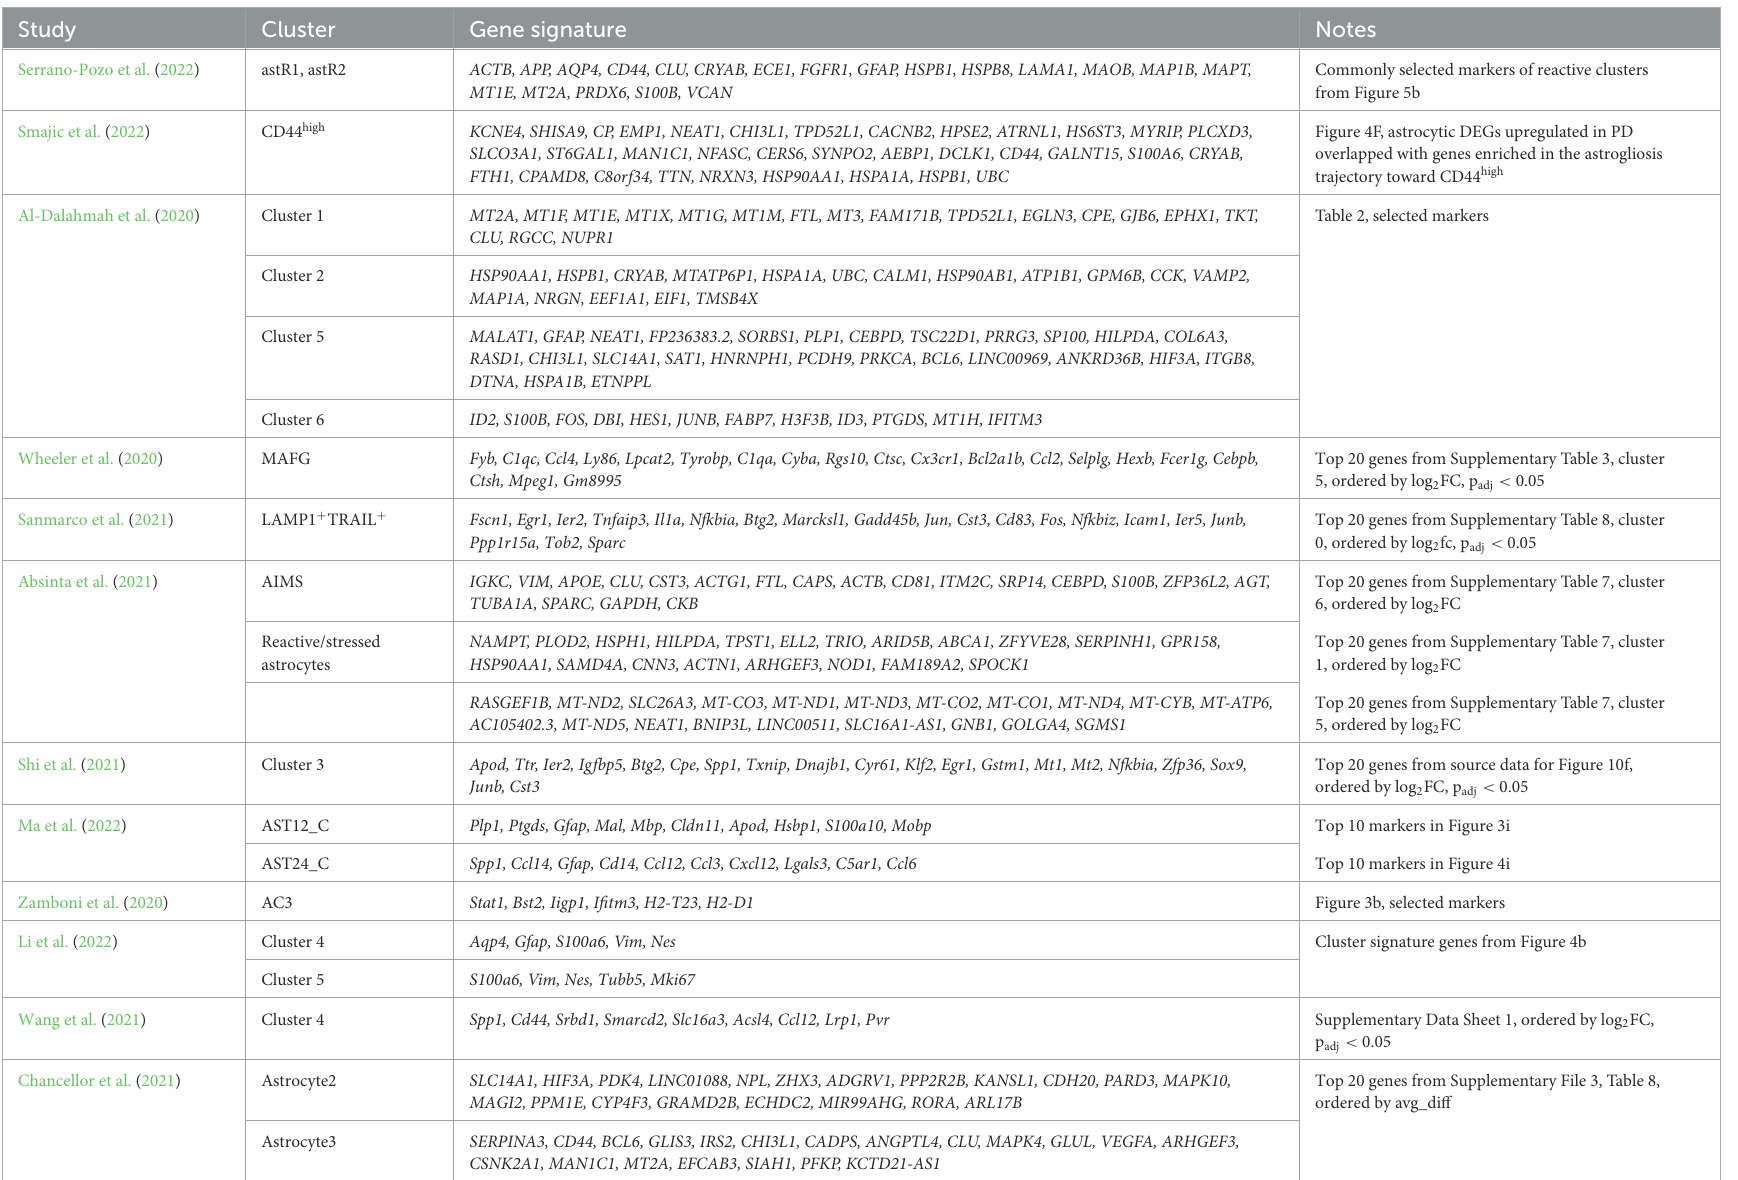
Figure 4F, astrocytic DEGs upregulated in PD overlapped with genes enriched in the astrogliosis trajectory toward CD44